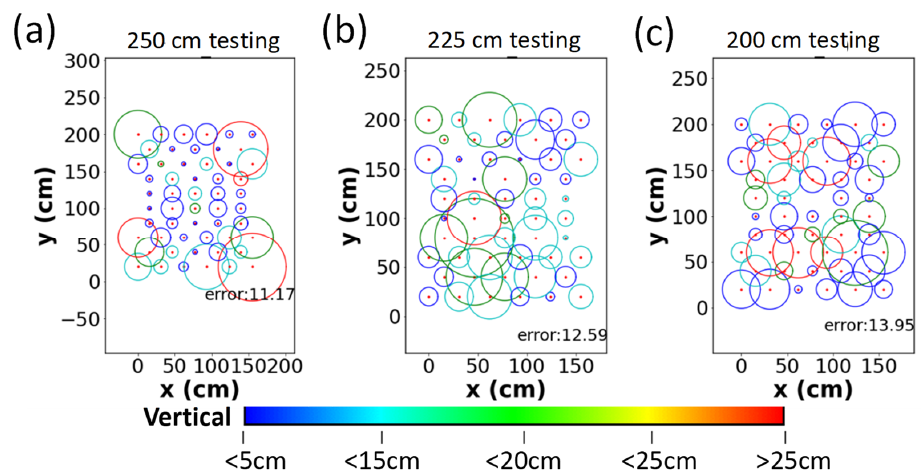
Figure 8. Experimental average error distributions of the testing points using the TSNN without RISE at the ( a ) 250 cm, ( b ) 225 cm, ( c ) 200 cm Rx planes.